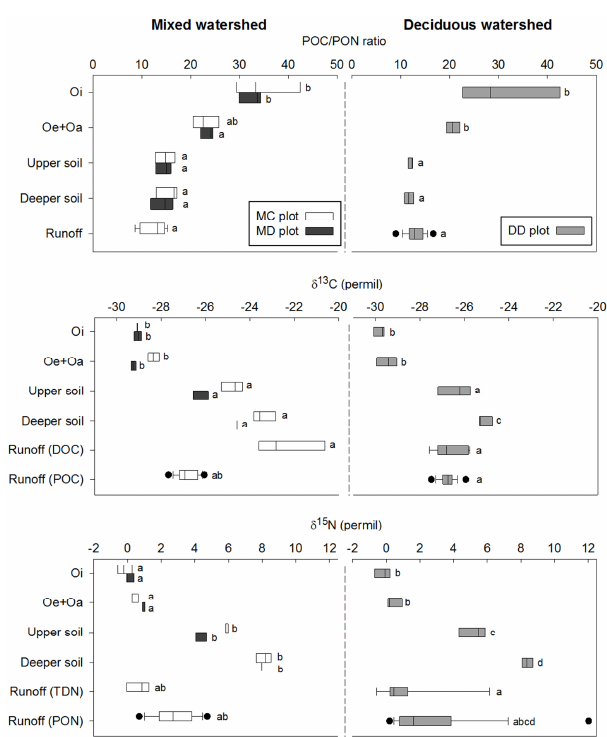
Figure 7. Range of particulate organic carbon and nitrogen ratio (POC / PON ratio), δ 13 C and δ 15 N in Oi, Oe + Oa, upper soil (0– 10cm depth), deeper soil (40–50cm depth at the MC and MD plot, 30–40cm depth at the DD plot), and runoff. Box plots display min- imum, lower quartile, median, upper quartile, maximum, and out- liers. Statistically significant differences between sample types (Oi, Oe + Oa, upper soil, deeper soil, and runoff) are indicated by differ- ent letters in the box plots (significance level of p <